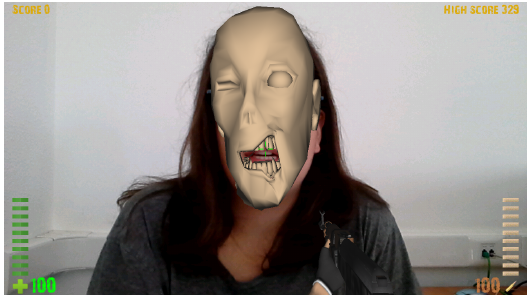
Figure 3: Result of the alignment between the face of the person and the virtual model.